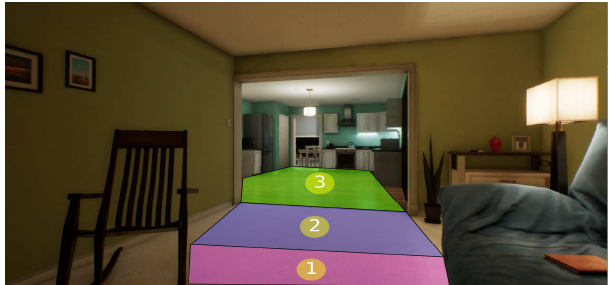
Figure 23. Environment division using navigation meshes for rooms 1 and 2.